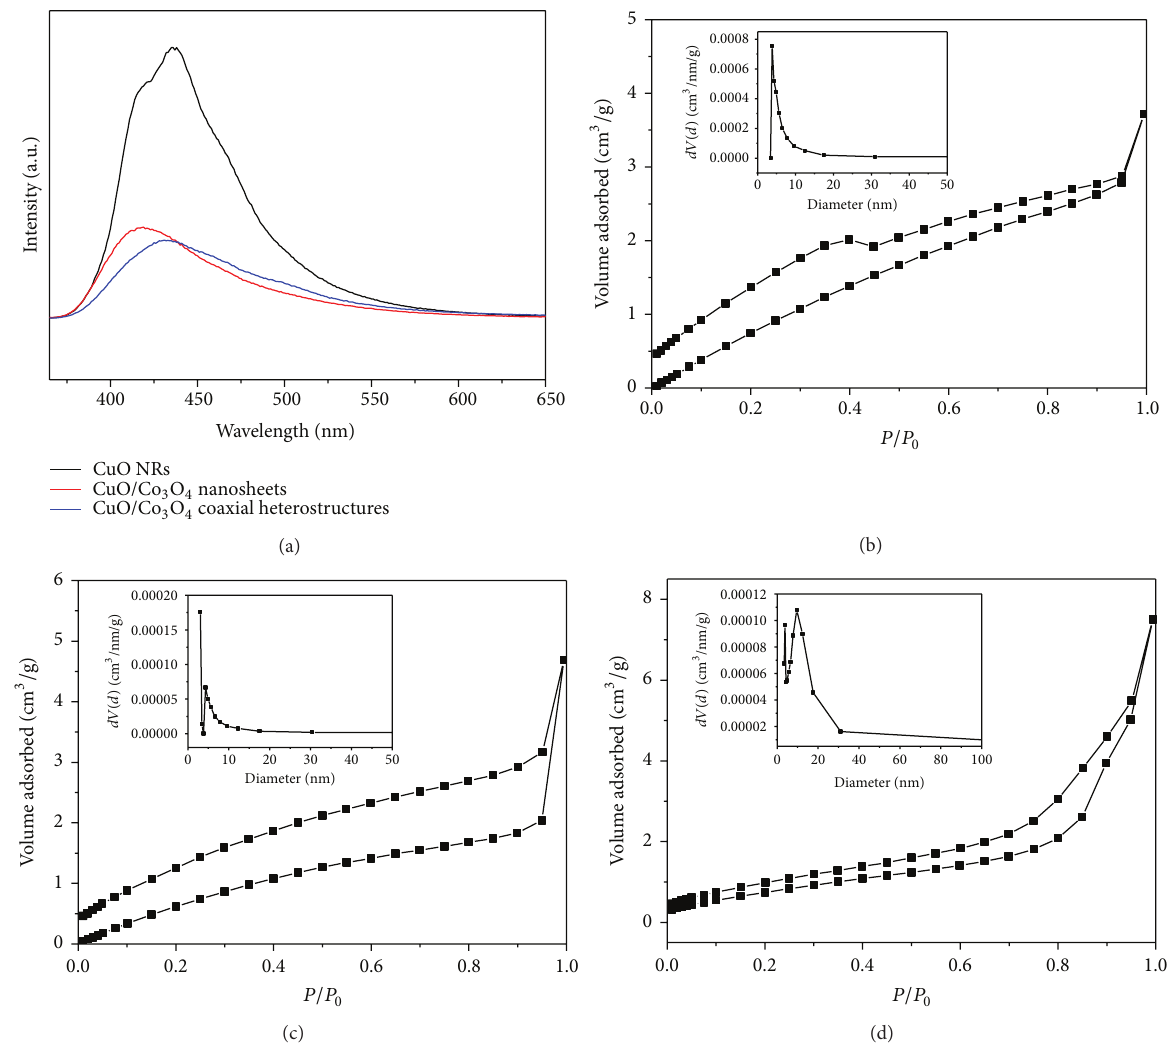
Figure 8: (a) The photoluminescence (PL) spectra of the CuO NRs, CuO/Co 3 O 4 coaxial heterostructures, and CuO/Co 3 O 4 nanosheets. Nitrogen adsorption-desorption isotherm for mesoporosity and BJH pore size distribution plot (inset): (b) CuO NRs; (c) CuO/Co 3 O 4 coaxial heterostructures; (d) CuO/Co 3 O 4